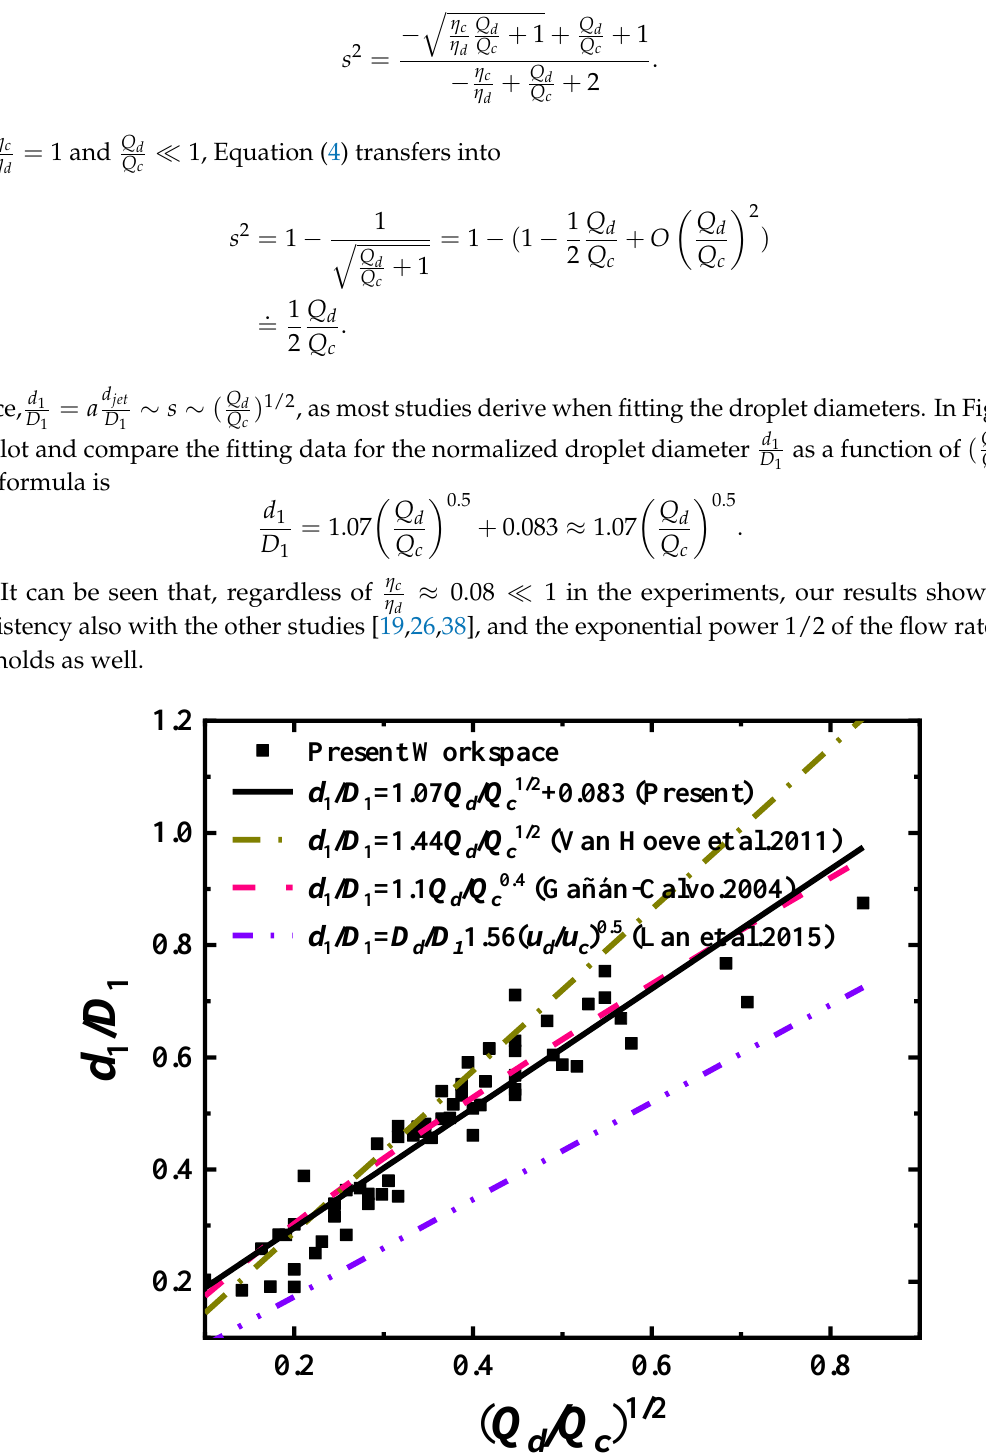
(cid:16) (cid:17) 0.5 Q d Q c